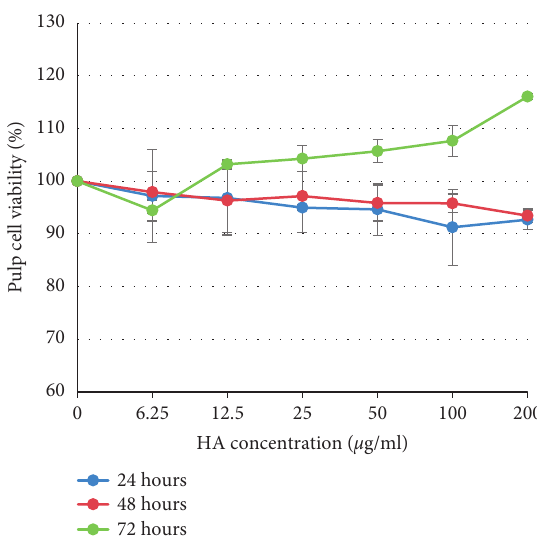
Figure 1: The viability of the pulp cells after treatment with dif- ferent concentrations of THA ( μ g/ml) as determined by MTTassay. Cell viability reached the highest percentage in the group treated with 200mg/ml THA for 72 hours.